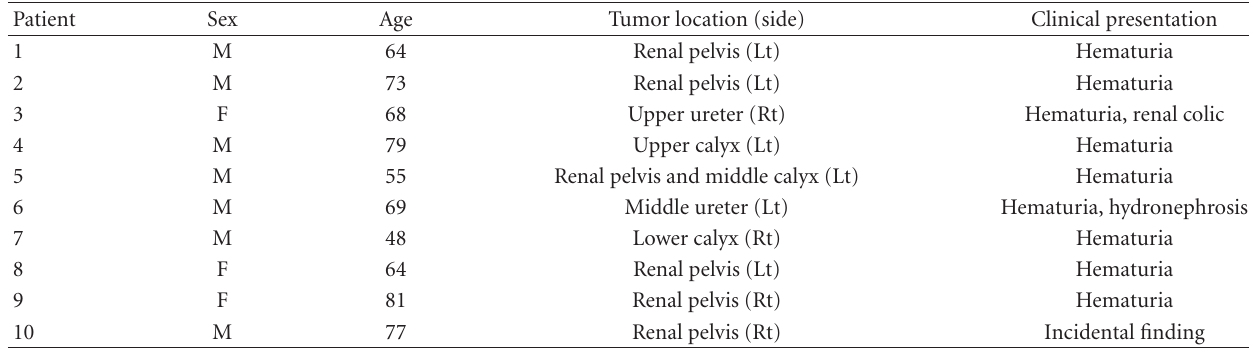
Table 1: Patients’